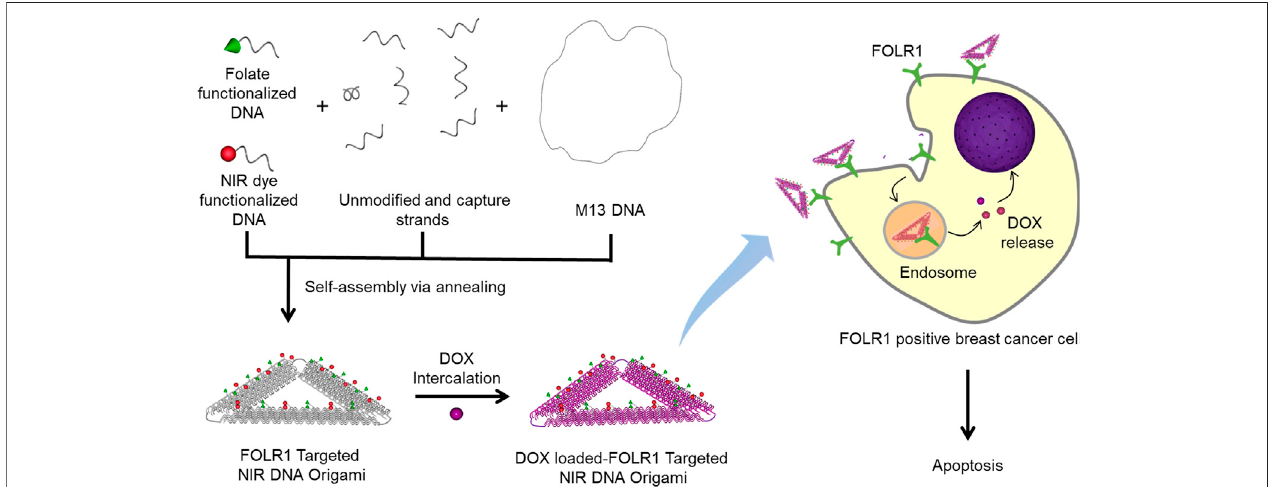
FIGURE 1 | Schematic representation of folate functionalized DNA origami for targeted delivery of DOX. The FOLR1 targeted NIR DNA origami is fabricated by mixing M13 DNA with unmodi fi ed staple strands, captures strands, folate, and NIR dye functionalized DNA. Capture strands contain 15 base long single-stranded overhang in the 5 ′ end that is uniquely complementary to folate functionalized/NIR dye functionalized strands. A well-known anticancer drug, DOX, was intercalated in folatefunctionalizedDNAorigamistructures.FOLR1positivebreastcancercellsselectivelyuptakefolatefunctionalizedDNAnanostructuresviareceptor-mediated endocytosis. DOX molecules are released from the endosomal compartment and translocate to the nucleus that result in cytotoxicity and cell death.